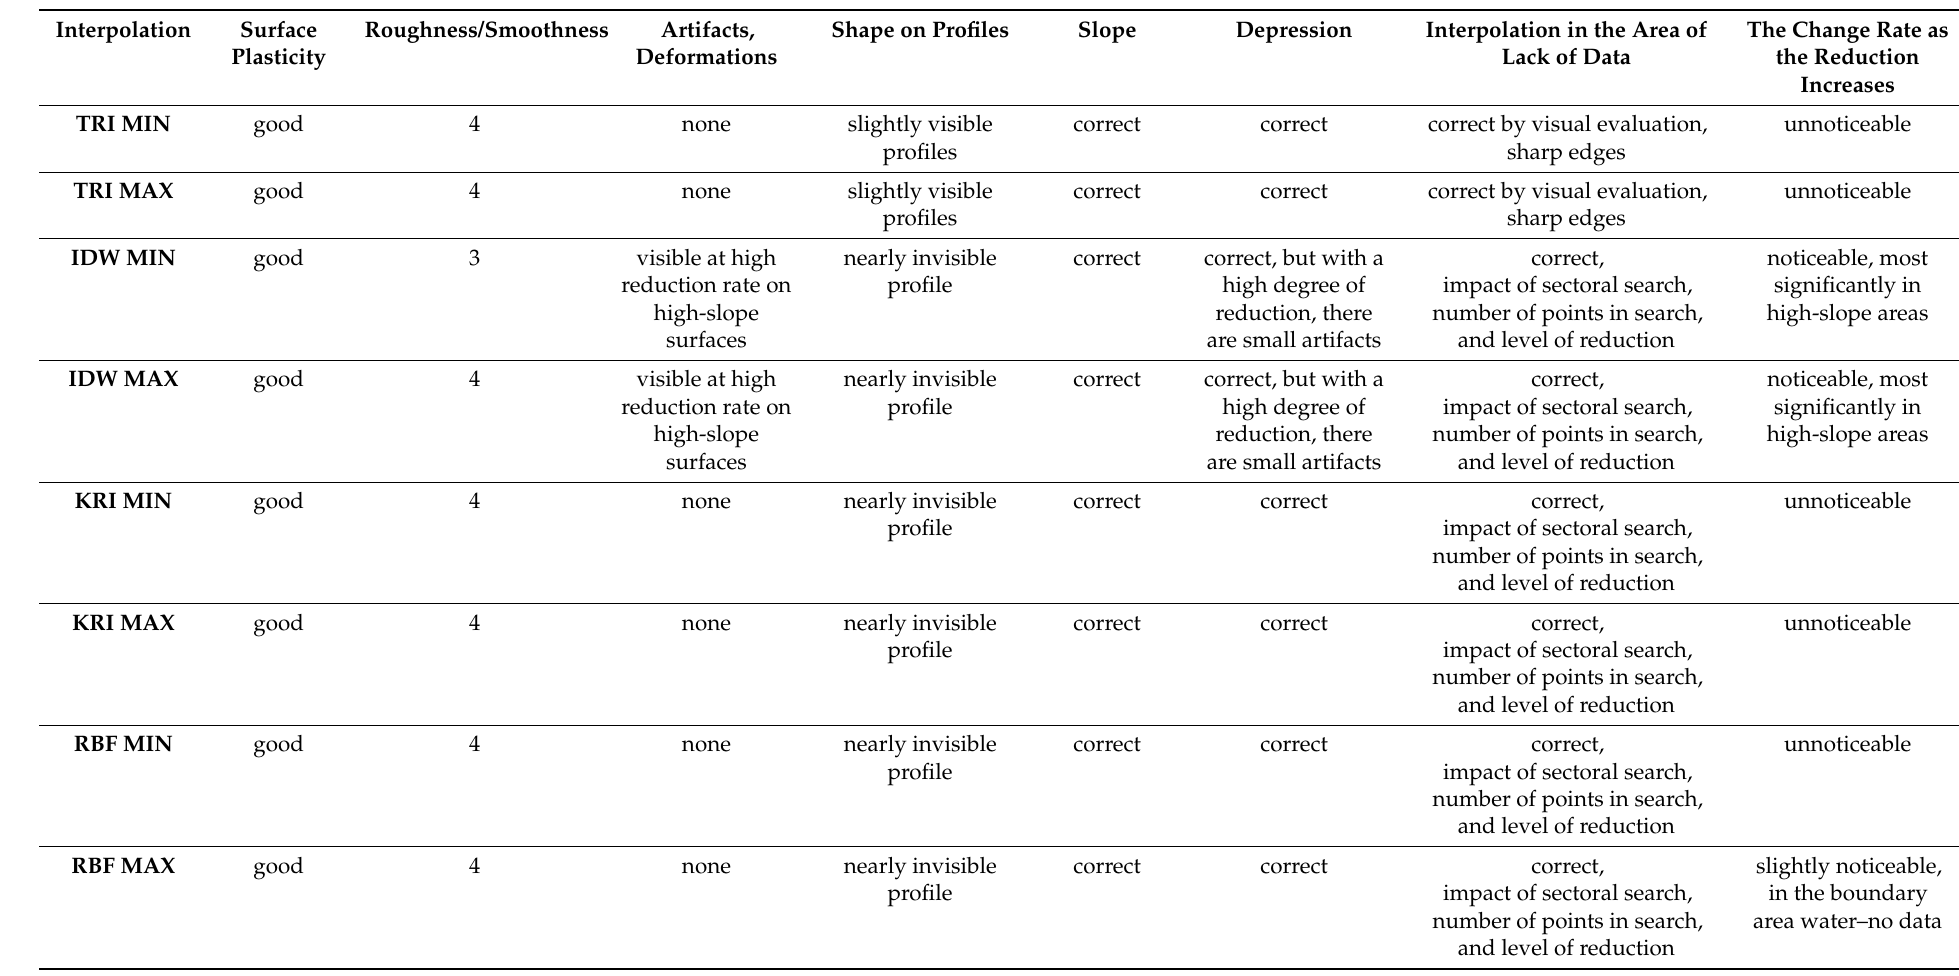
Table A1. Qualitative analysis for surfaces created from ABES